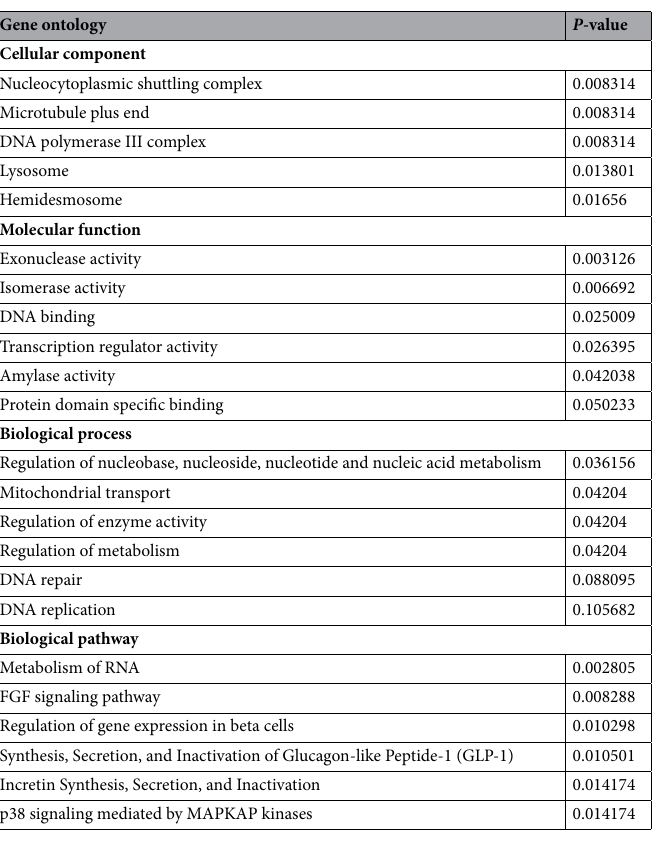
Table 4. Black module functional enrichment results. www. kegg. jp/ kegg/ kegg1. html